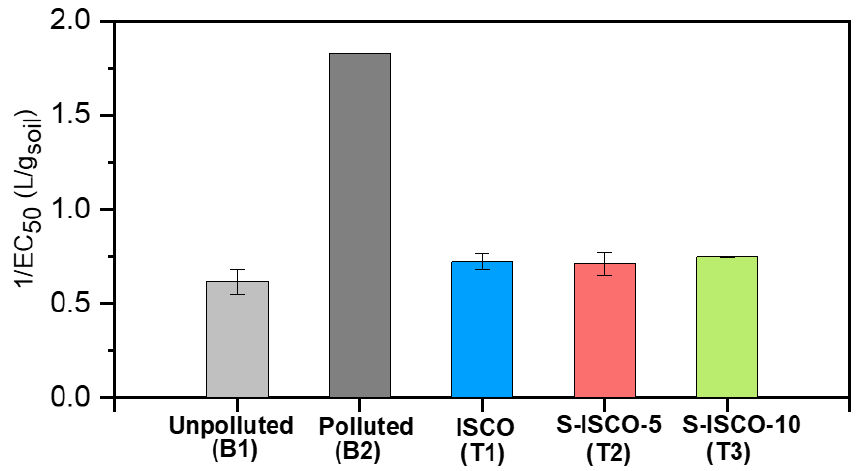
Figure 2. Soil toxicity (1/EC 50, Microtox ® mBSPT) of the unpolluted, polluted, and treated